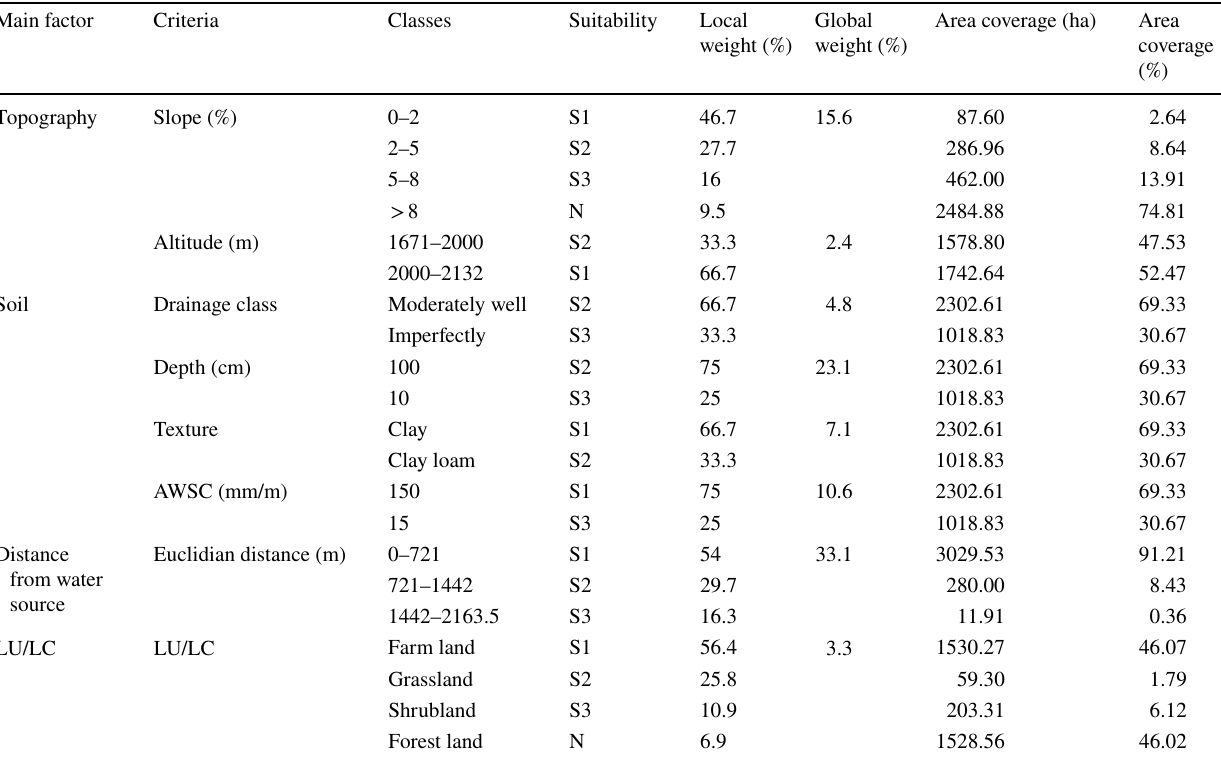
Table 8 Factors for surface irrigation land suitability assessment Main